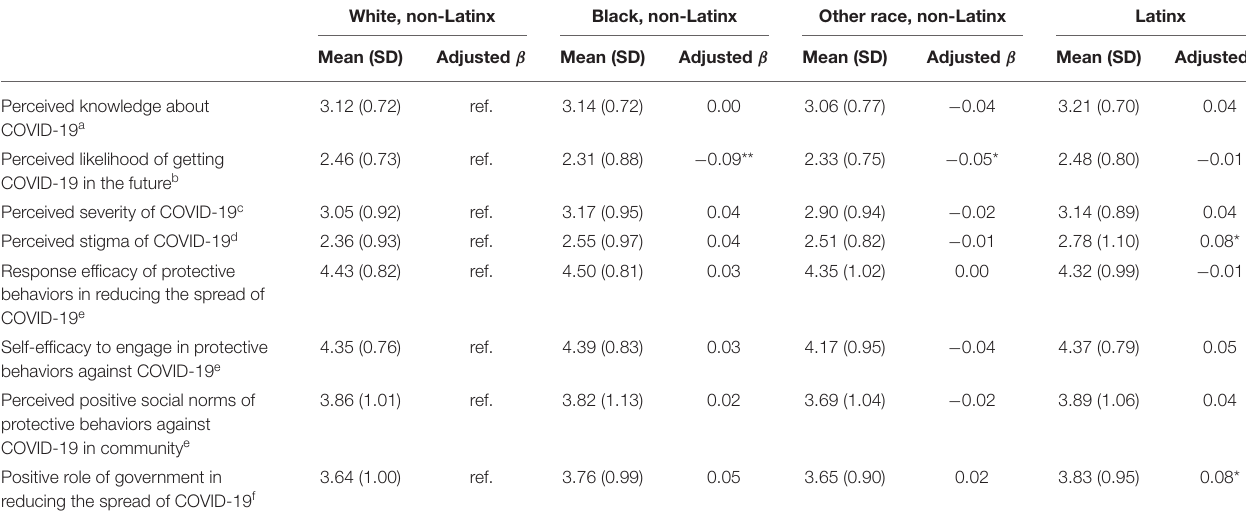
TABLE 3 | Perceived knowledge and attitudes and beliefs about COVID-19 across racial/ethnic